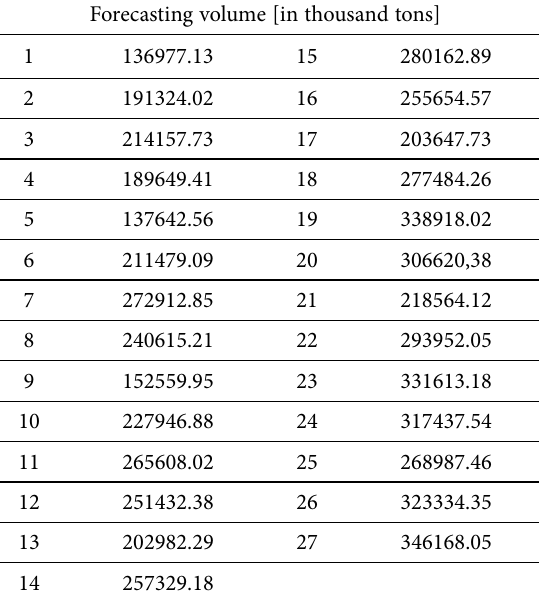
Table 2. Forecasting results given applying the artificial immune system in harmonic analysis